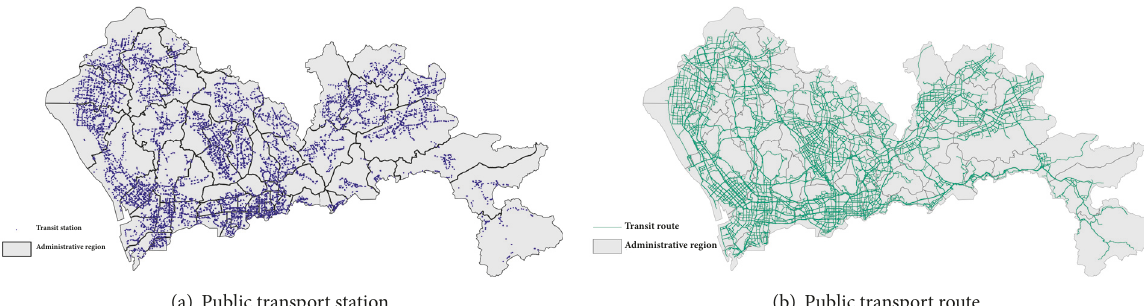
Figure 3: Shenzhen public transportation network diagram.